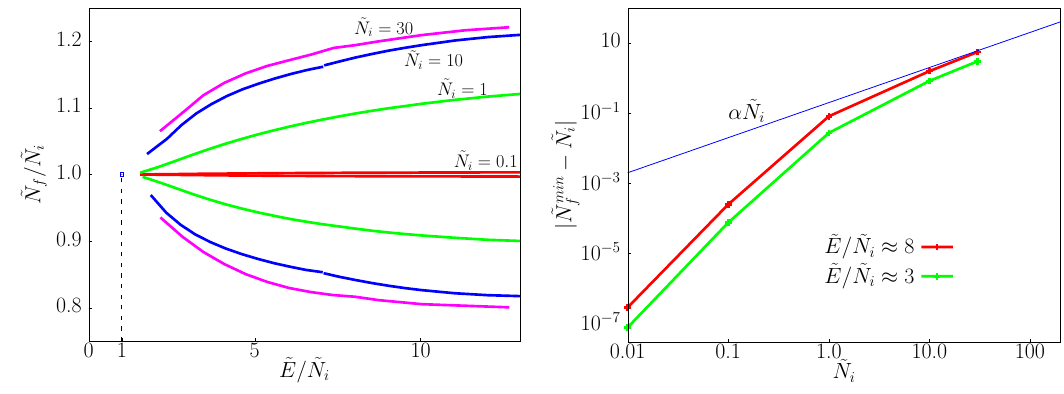
Figure 18 . Left panel: the classically allowed regions in ( ~ E; ~ N f ) plane for di(cid:11)erent ~ N i . Right panel: the di(cid:11)erence j ~ N min (cid:0) ~ N i j as a function of ~ N i f